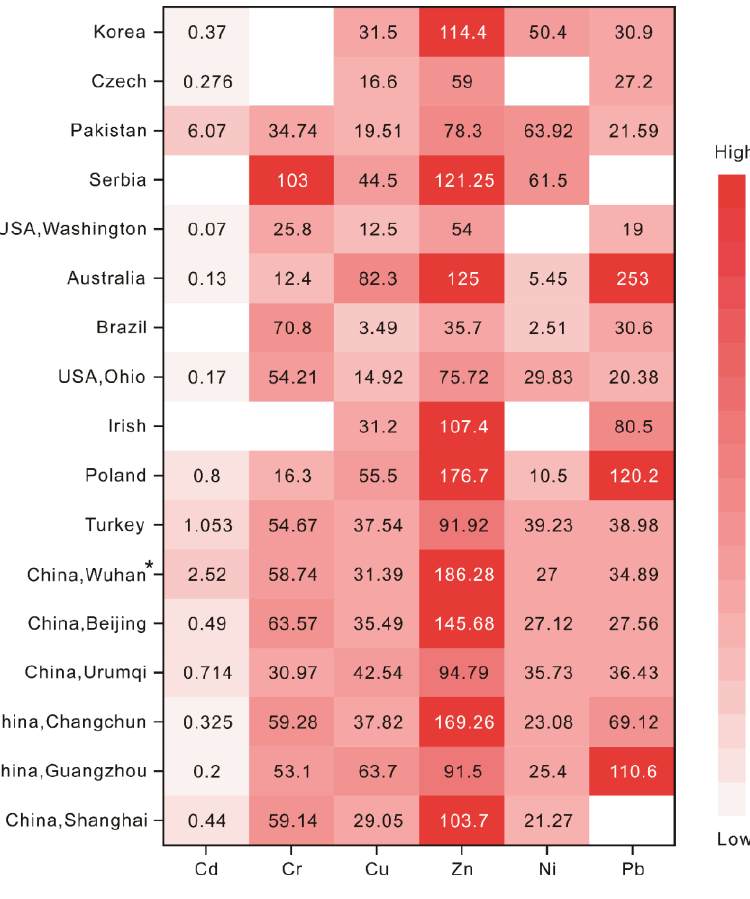
Figure 2. Comparative analysis of soil heavy metals in Wuhan*(this study) and in different regions (mg·kg −1 ). (mg · kg − 1